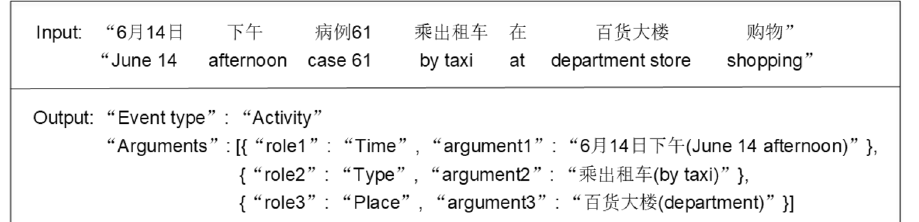
Fig. 2 Extraction results of dif- ferent EAE